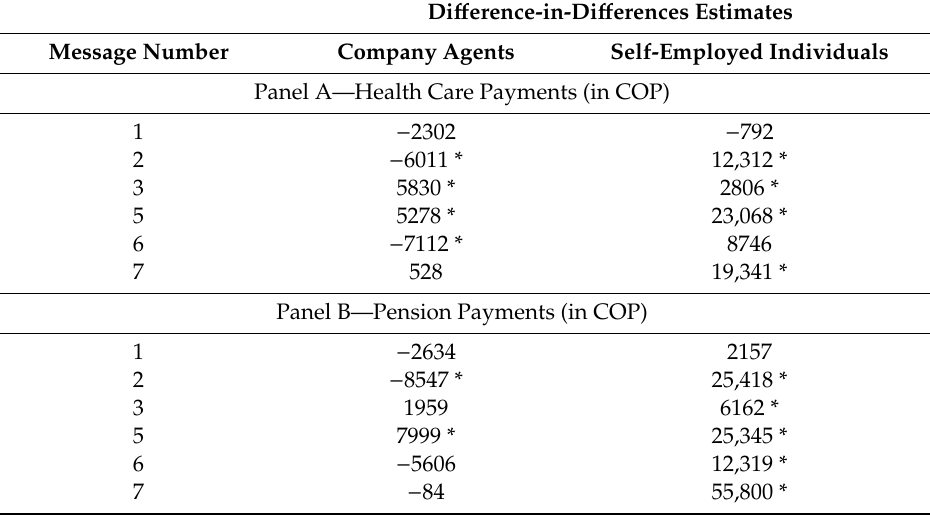
Table 6. Di ff erence-in-Di ff erences Estimates with No Message as Control Group—